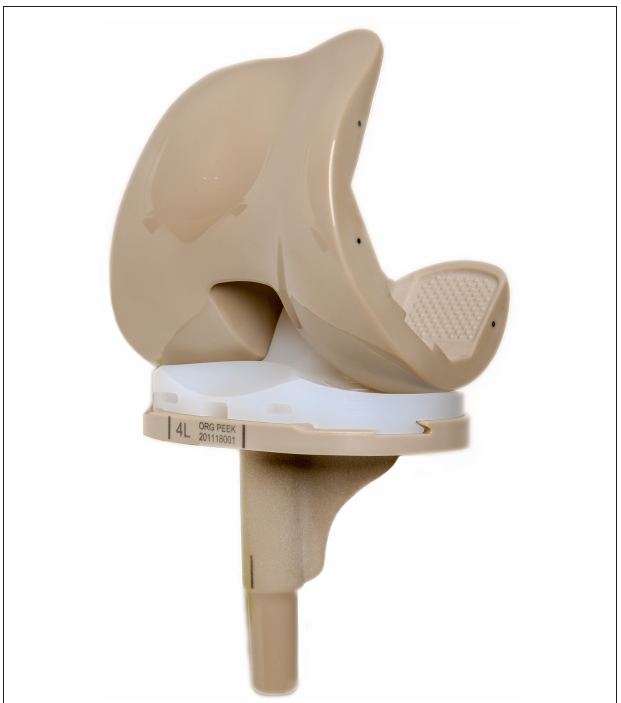
FIGURE 1 | The complete knee prosthesis consists of the PEEK femoral component, PEEK tibial component, and an all-polyethylene bearing. PEEK, polyetheretherketone.